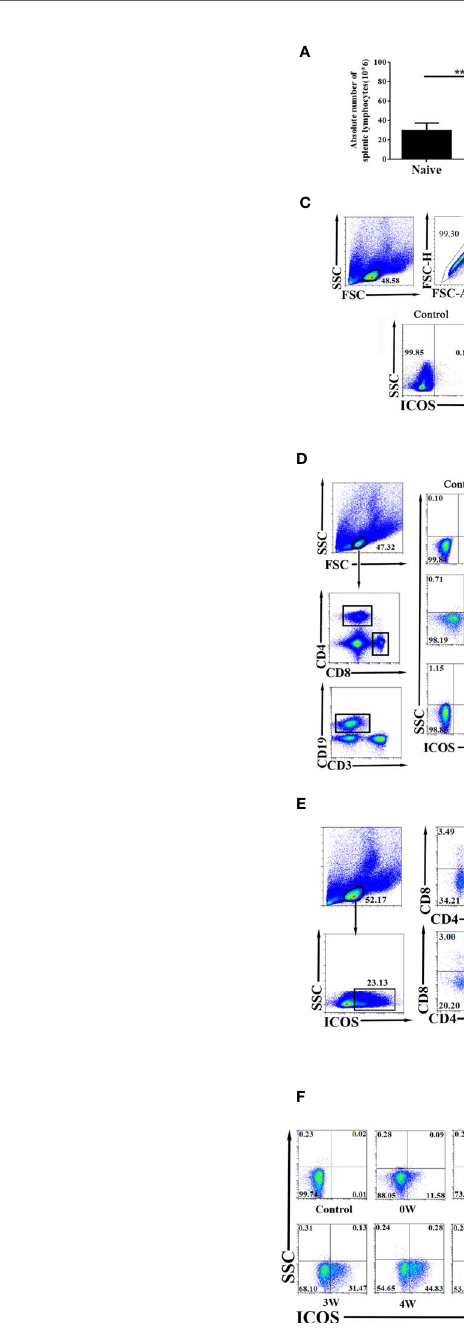
FIGURE 1 | Schistosoma japonicum infection-induced increased expression of ICOS molecules in Th cells in the spleen. Female C57BL/6 mice were infected with 40 ± 5 S. japonicum cercariae per mouse, and 5 – 6 weeks after infection, mice were euthanized. (A) Number changes of splenic lymphocytes in the naive group and S. japonicum infection group. Each group included six mice. (B) Transcriptional expression of ICOS from splenic lymphocytes of naive and S. japonicum -infected mice was detected by qRT-PCR. Each group included six mice. (C) The ICOS expression on mononuclear cells from naive and S. japonicum -infected mice was detected by fl ow cytometry. All the doublet cells, dead cells, and nonlymphoid cells were excluded from fl ow cytometry data. The control group is the fl uorescence minus one (FMO) control. (D) ICOS expression on CD4 + Th cells, CD8 + T cells, and CD19 + B cells from naive and infected mice was detected by FACS. (E) ICOS + cells from WT and infected mice mononuclear cells were gated fi rstly. The distributions of ICOS in different cell populations were shown. Data are representative of three experiments. (F) Dynamic changes of ICOS expression in CD4 + T cells from week 1 after infection; naive control was set (0 week). The average of three independent experiments with fi ve to six mice per group was shown and repeated three times with similar results. The error bars are SD, * P < 0.05, ** P < 0.01, *** P < 0.001, and ns , not signi fi cant ( P >